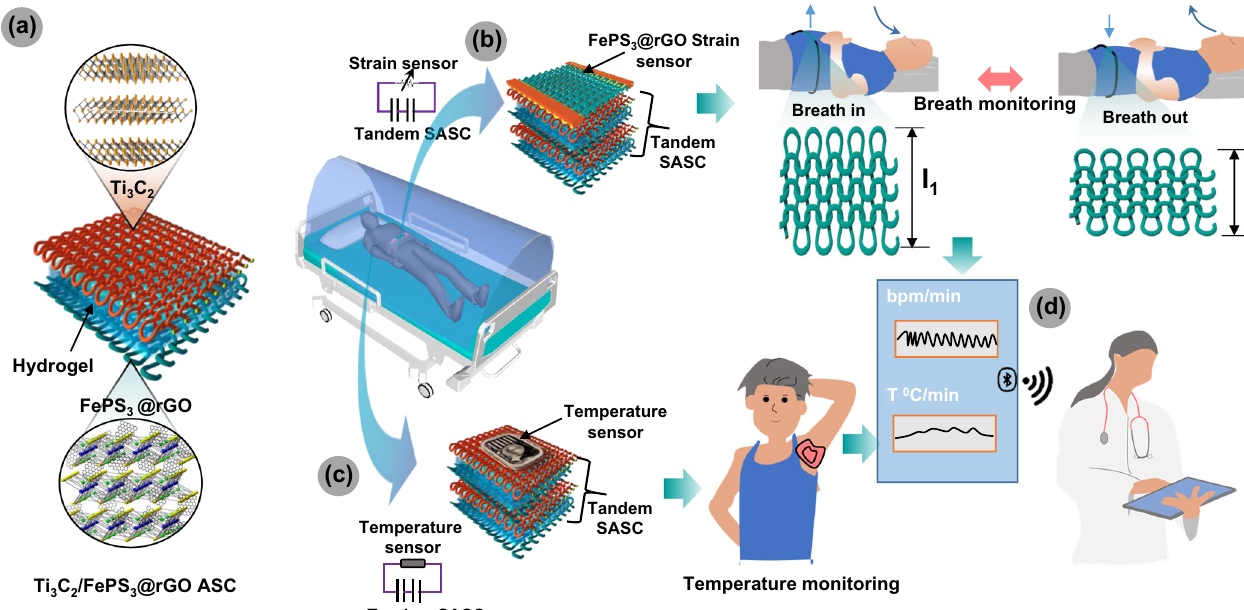
Fig. 1 Telemedicine platform for remotely health monitoring by integrated 2D FePS 3 @rGO and Ti 3 C 2 based wearable devices. a Schematic illustration of the Ti 3 C 2 /FePS 3 @rGO SASC. b Integrated FePS 3 @rGO-based strain sensor with series-connected two SASC for real- time breath monitoring. c Integrated temperature sensor with series-connected two SASC for real-time body temperature monitoring. d Bluetooth or Wi-Fi signal sources used to transfer breathing and temperature data to a healthcare